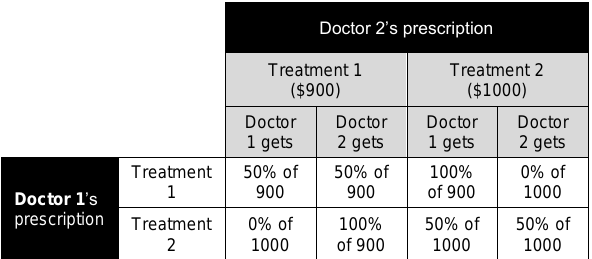
Table 1: Payout structure for each possible combination of prescription